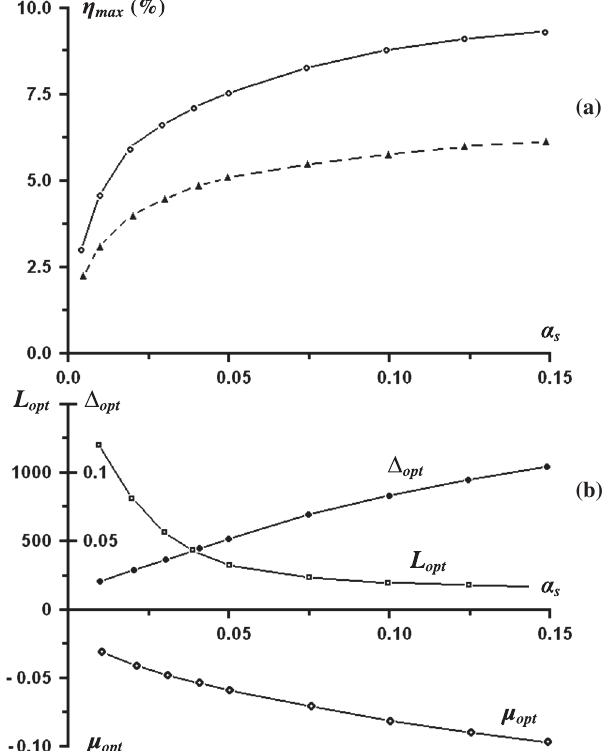
FIG. 15. The dependence of (a) maximum efficiency (cid:7) well as (b) optimal value of parameters (cid:9) opt the amplitude of the signal wave (cid:4) FEL oscillator with a strong conventional guide field (solid line) and a reversed guide field for the same pitch factor of the electrons [dashed line in